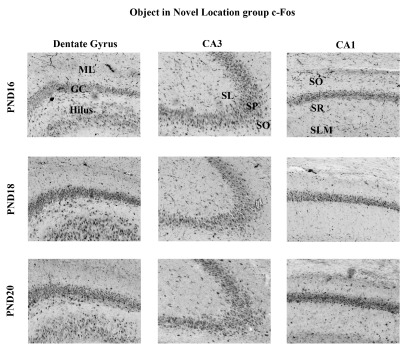
Representative c-Fos labeling in the hippocampus.Representative images for immunohistochemical localization of c-Fos in the dentate gyrus (DG), CA3 and CA1 regions from rats included in the ONL condition. Top row shows sections from PND16; middle row from PND18; bottom row from PND20. Images were taken at 10×. Abbreviations: ML: molecular layer of the dentate gyrus; GC: granule cells; S:
stratum lucidum; SP:
stratum pyramidale; SO:
stratum oriens; SR:
stratum radiatum; SLM:
stratum lacunosum moleculare.